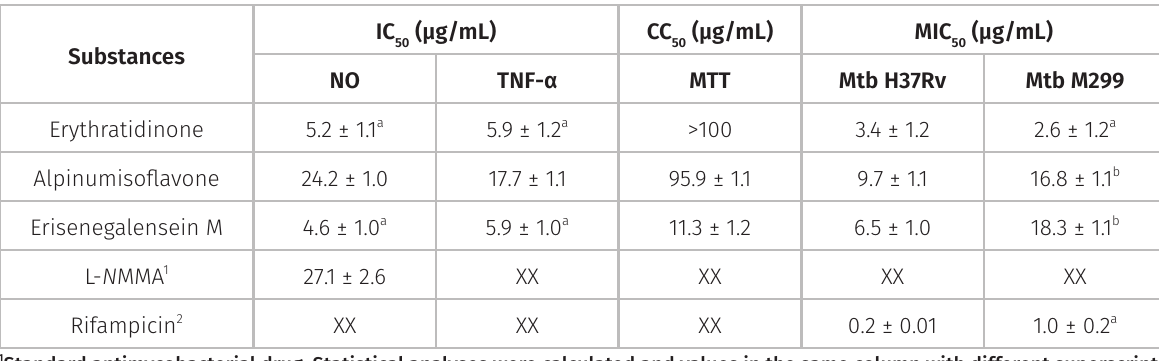
Table II. Inhibitory effects of isolated substances from Erythrina verna on production of NO and TNF-α by LPS- stimulated RAW 264.7 macrophages, evaluation of cytotoxicity and on growth of the laboratory M. tuberculosis strain H37Rv and clinical isolate M. tuberculosis M299.